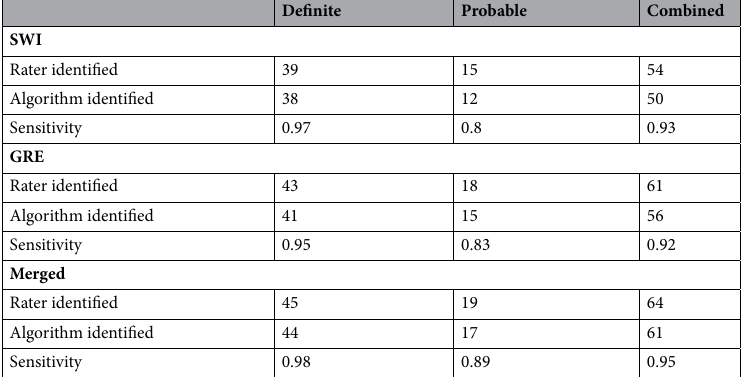
Table 2. Algorithm sensitivity results. An artifact was labeled as a “definite” microbleed if all three raters agreed that the artifact was a microbleed, and as a “probable” microbleed if two raters agreed that it was a microbleed. This table shows the sensitivity results of the algorithm across these different labels. Note that in a study using only visual ratings, the final column (combining the definite and probable ratings) would be the number typically